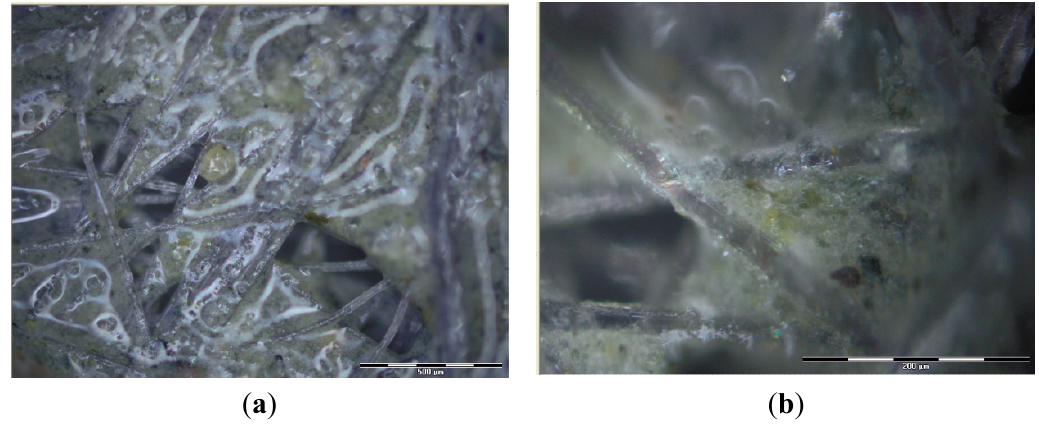
Figure 8. Filter Rig No. 2 geotextile layer at 5× magnification ( a ); and 20× magnification ( b